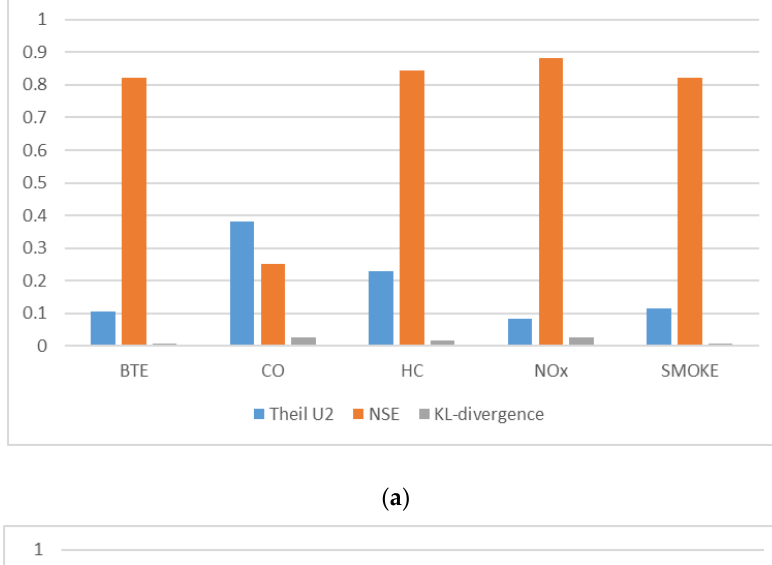
Figure 5. Illustration of R 2 and RMSE of the model for ( a ) 3 neurons; ( b ) 5 neurons; and ( c ) 7 neurons.